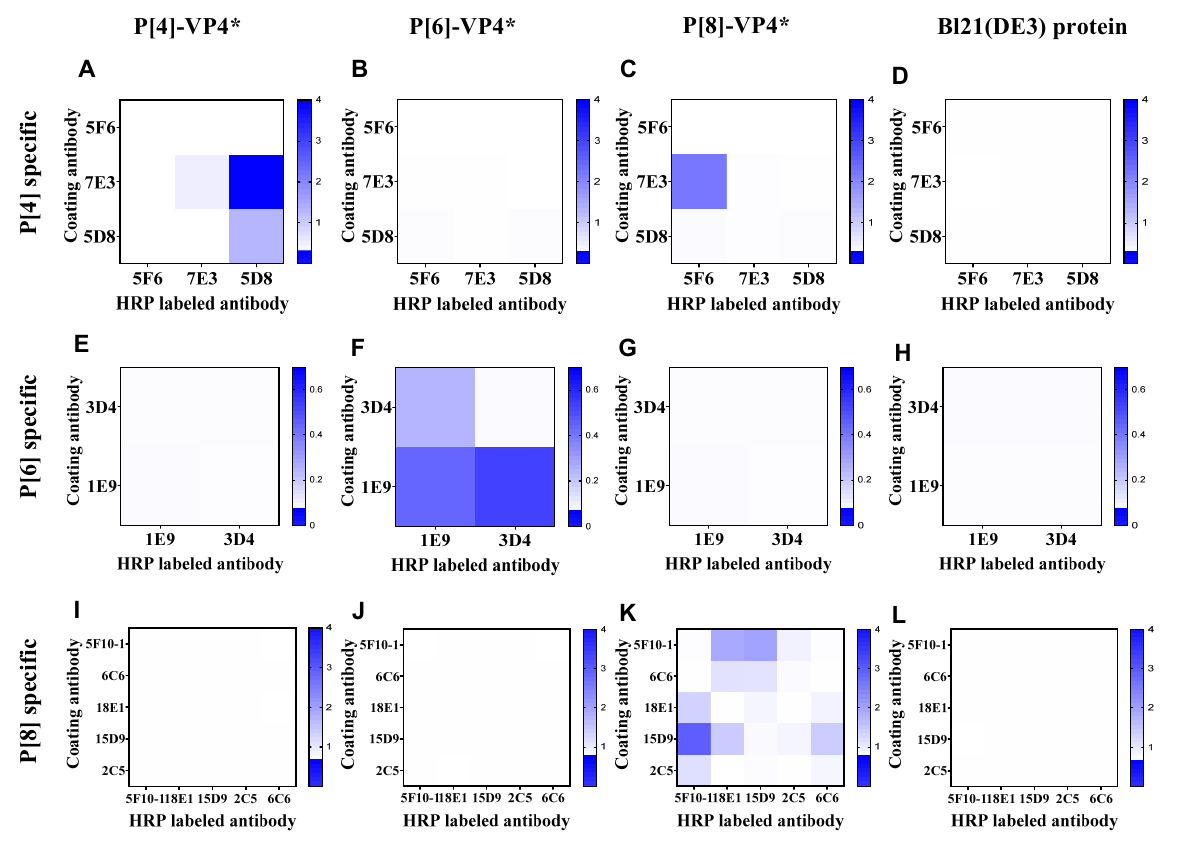
Figure 1. The reactivity of the antibody pairs for P[4], P[6], P[8]-VP4*, and Bl21(DE3) E. coli lysate as examined by checkerboard. ( A – D ) The reactivity of P[4]-VP4*-specific mAb pairs for detecting 100 ng/mL P[4]-VP4*, 100 ng/mL P[6]-VP4*, 100 ng/mL P[8]-VP4*, and the cell lysate of Bl21(DE3); ( E –